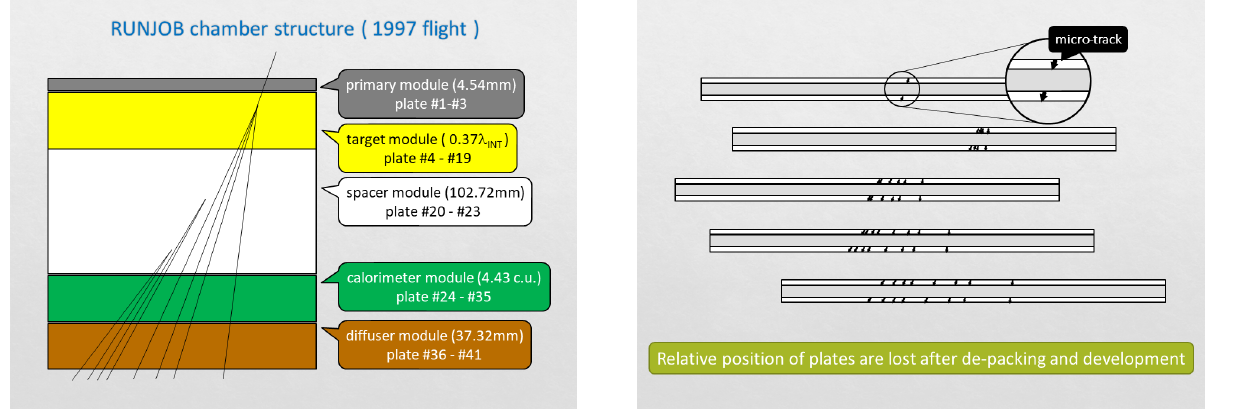
Fig 2. Structure of a RUNJOB chamber for the 1997 flight.